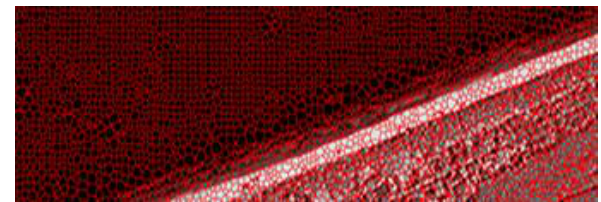
Figure 2. Created superpixels.